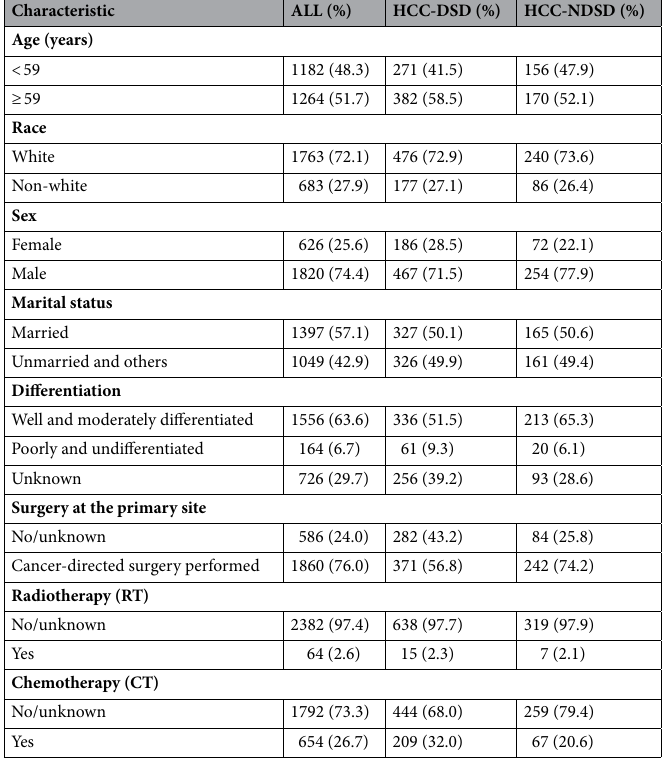
Table 1. Baseline characteristics of stage Ia HCC patients. HCC: Hepatocellular carcinoma; DSD: disease- specific death; NDSD: non disease-specific